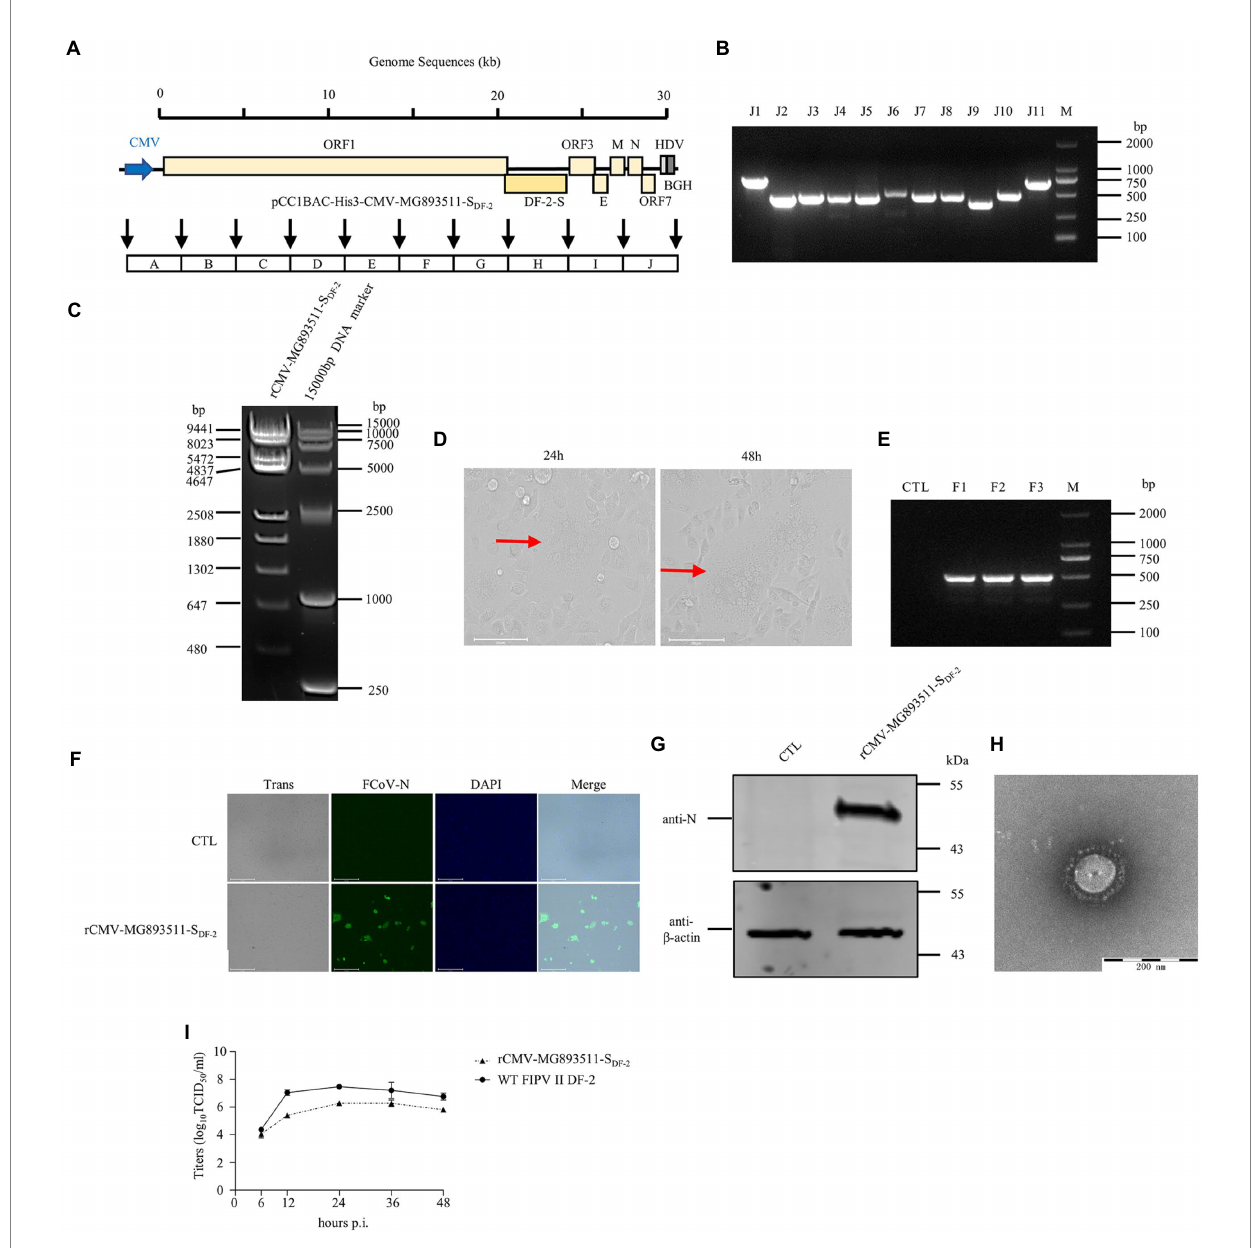
FIGURE 4 The recovery and identification of the chimeric FECV strain of MG893511-S DF-2 . (A) Strategy diagram for the construction of pCC1BAC-His3-CMV- Black-S DF-2 . (B) Identification of fragment interfaces of the plasmids recovered from bacteria. (C) Enzyme digestion of pCC1BAC-His3-CMV-MG893511- S DF-2 plasmid ( Bgl II). (D) Significant cytopathic effects (CPE) were observed at 24 and 48 h after infection with CRFK cells. (E) PCR identification of the rescued recombinant FCoV virus. (F) and (G) rCMV-MG893511-S DF-2 virus infected CRFK cells for 12 h was identified by IFA (Scale Bar, 275 μ m) and WB. (H) Electron microscopy of the purified virus. (I) Growth kinetics of rCMV-MG893511-S DF-2 and WT FIPV II DF-2 after infection of CRFK cells at an MOI of 0.01. wt, wild